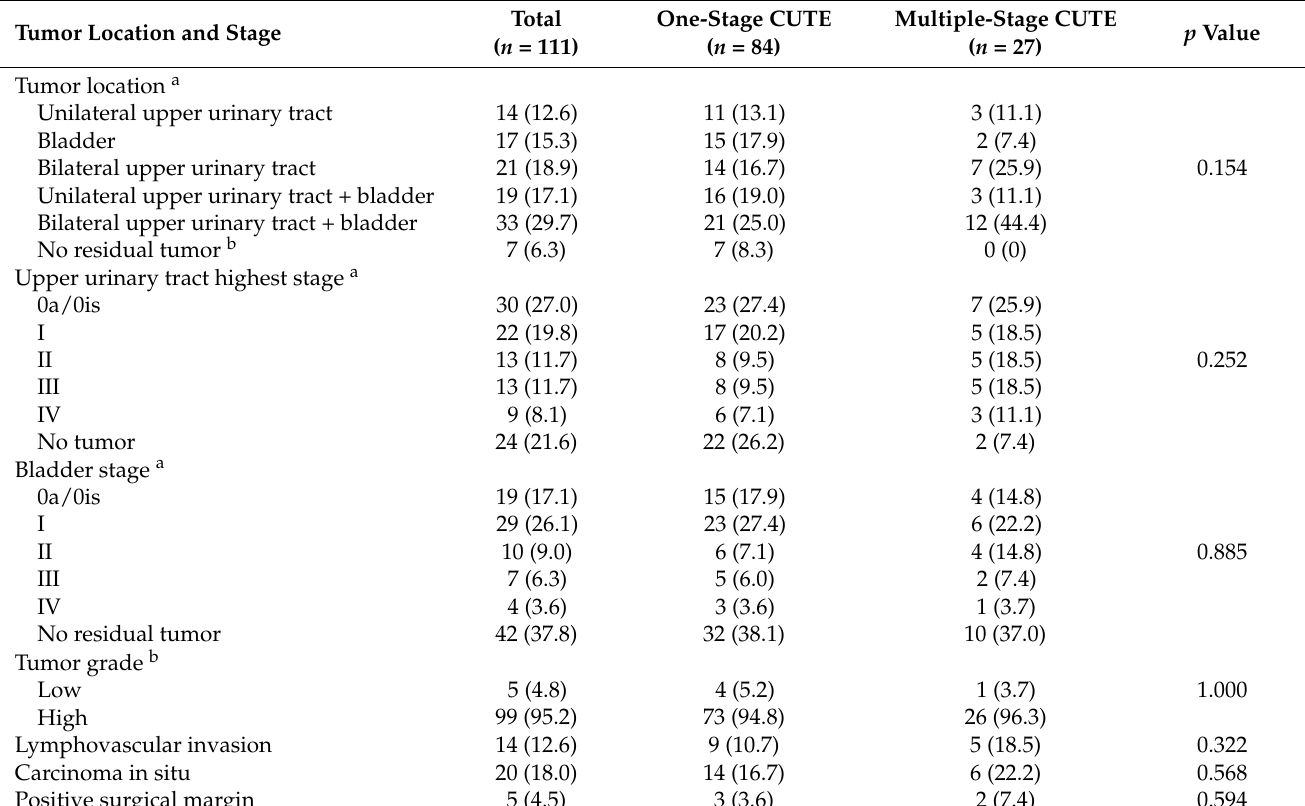
Table 2. Pathological